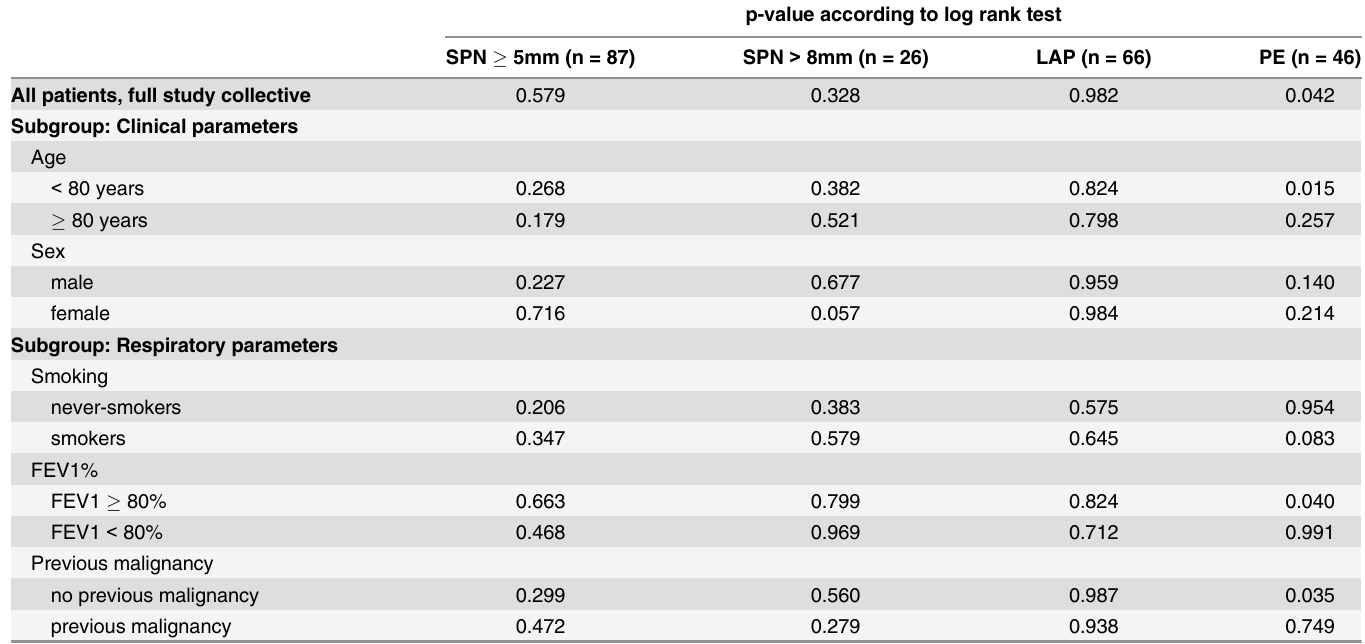
Table 4. Prognostic analysis for suspicious radiologic findings ( i . e . SPN, LAP and PE) in patients under TAVI evaluation with complete follow-up data (n = 237 patients).